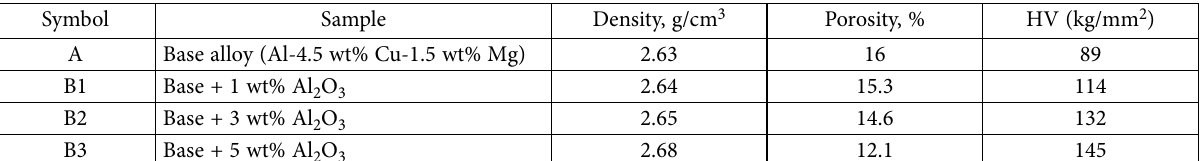
Table 3. Density, porosity and microhardness of nanocomposities after sintering at 560 °C for 60 min. Symbol Sample Density, g/cm